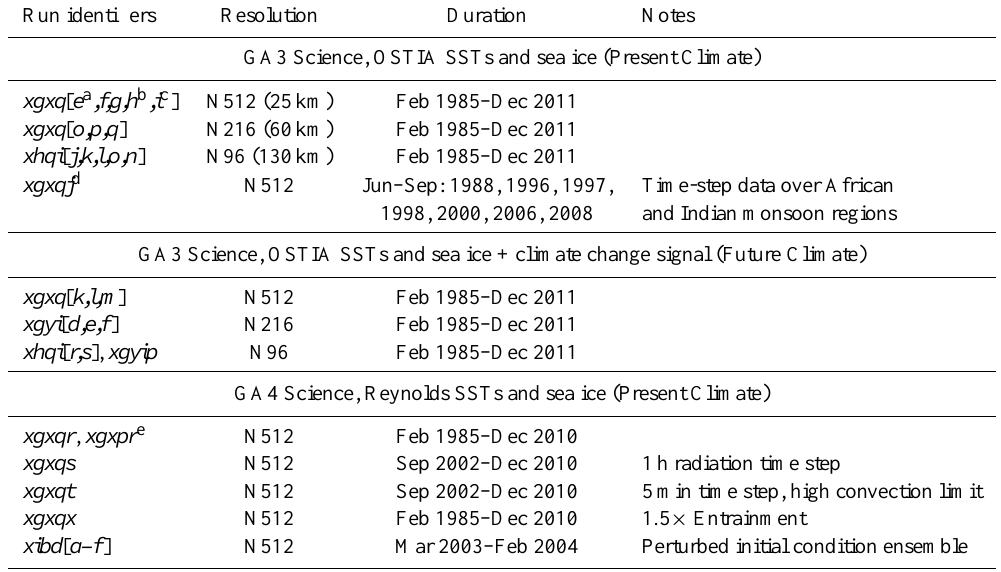
Table 4. Specification of the runs in the UPSCALE data